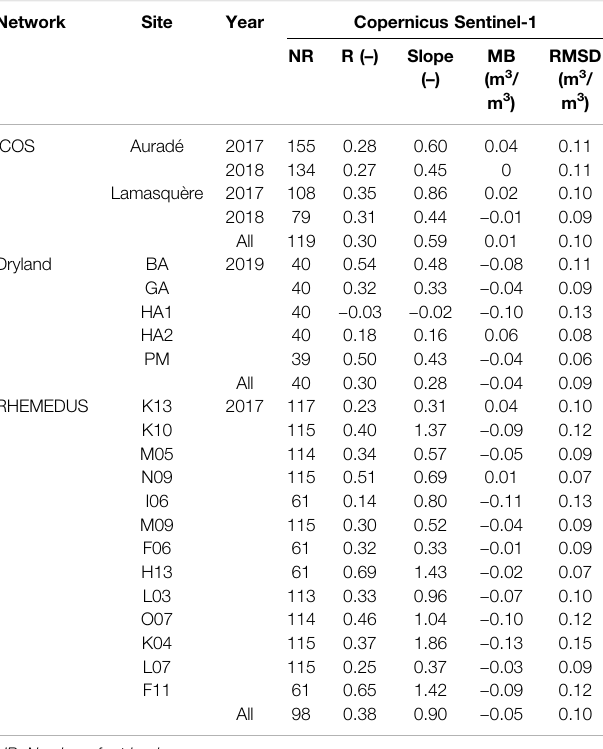
TABLE 5 | Statistical results in terms of correlation (R), slope of the linear regression (Slope), mean bias (MB) and RMSD between SMAP/S1 1 km resolution satellite product and in situ